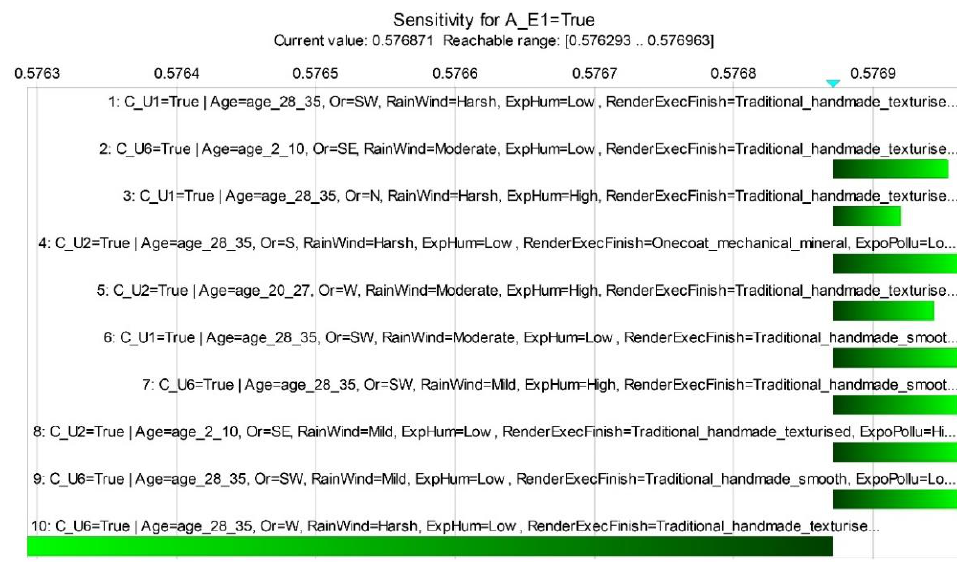
Figure 5. Tornado diagram analysing the sensitivity of “A-E1 Graffiti” (true = 58%; red bars: negative change; green bars: positive change).